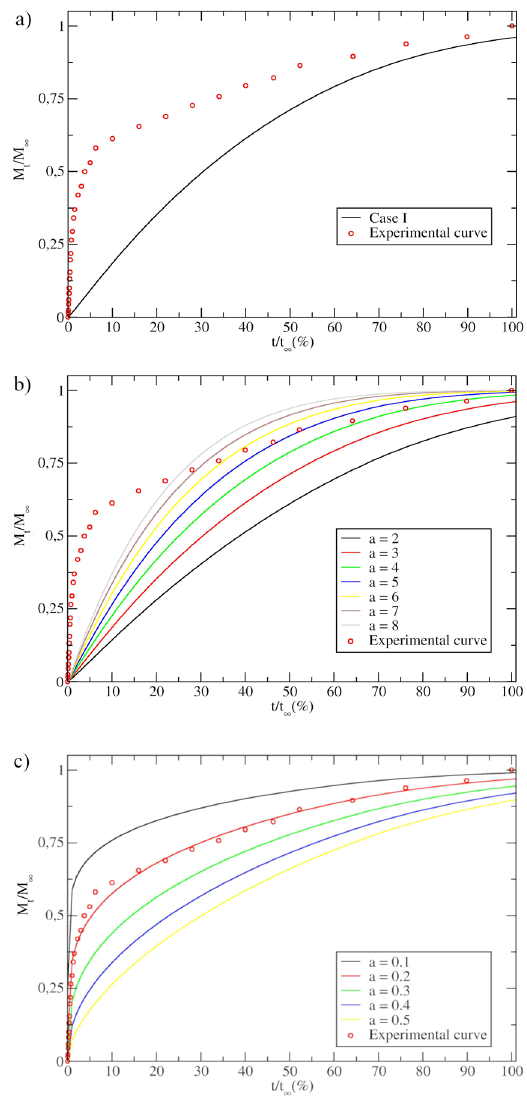
Figure 5. Herbicide release percentage as function of the normalized time. The parameters used for the root type relation were E p = 50, q = 0.06 and a = 0.2. Black curve represents the case III model, the green one the Korsmeyer-Peppas model and the red circles represent the experimental